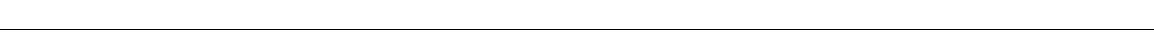
are dominant in specifying the efficiency of CDS translation.